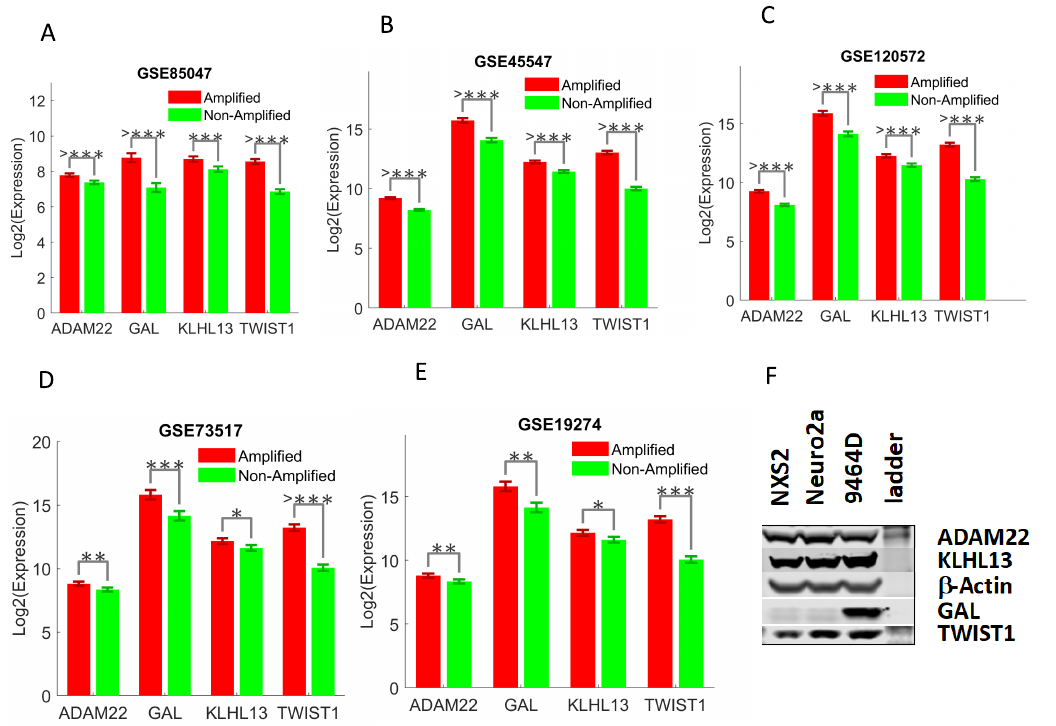
Figure 3. Four UHR-NB associated genes in MYCN amplified and non-amplified Tumors in five additional cohorts and mouse cell lines. The error bar denoted the mean expressions plus and minus one standard deviation. The raw p -values from student’s t test were reported on ( A – E ): *: p = 0.05–0.01, **: p = 0.01–0.001, ***: p = 0.001–0.0001, and > ***: p < 0.0001. ( F ): mouse cell lines, where NXS2